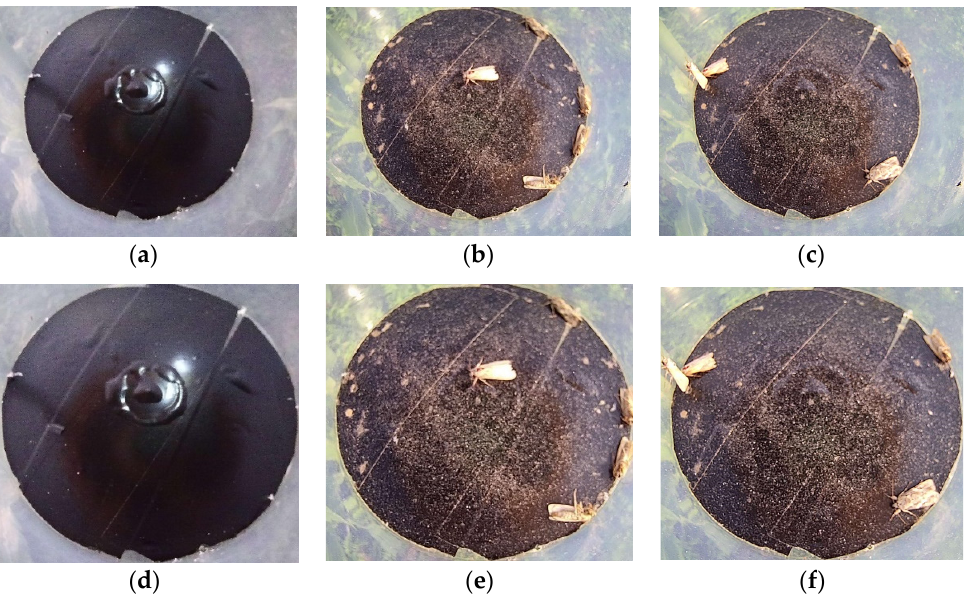
Figure 8. Original background and S. frugiperda images. ( a ) Original background image. ( b ) Original S. frugiperda image with light spot. ( c ) Image with S. frugiperda at the bottom edge of bucket. ( d ) Cropping image of background. ( e ) Cropping image of S. frugiperda with light spot. ( f ) Cropping image with S. frugiperda at the bottom edge of bucket.